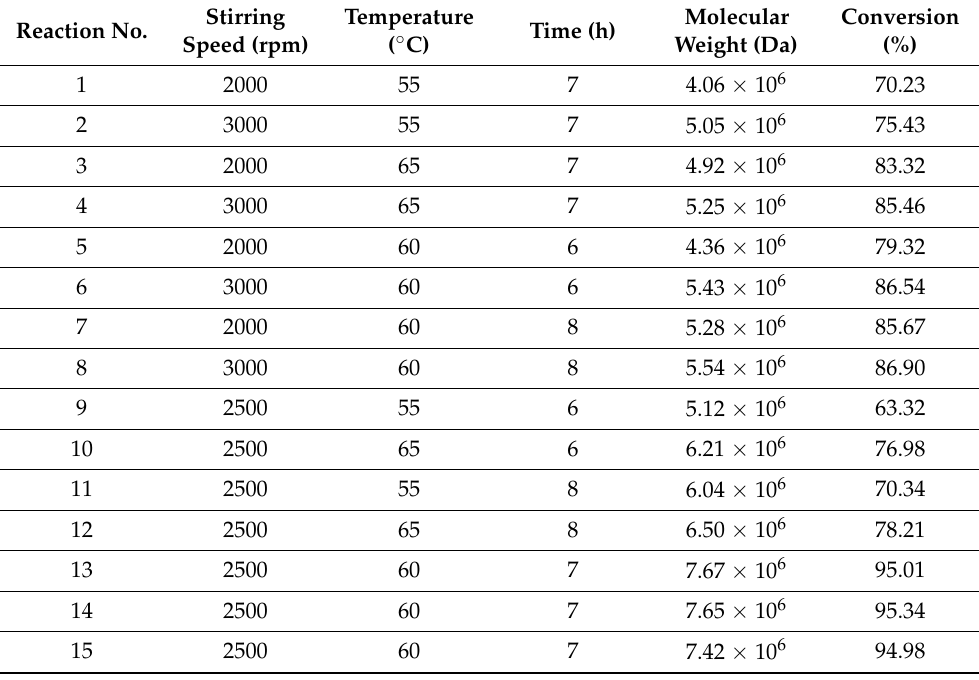
Table 1. Results of the actual trial synthesis.